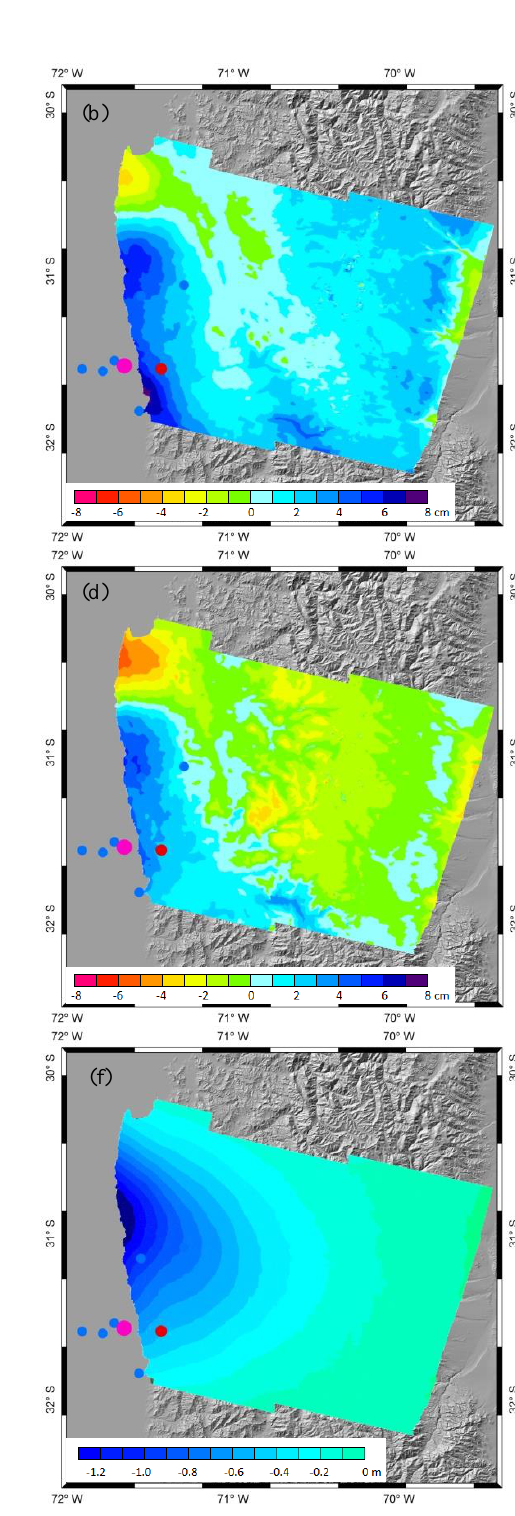
Figure 4. (a) and (b) Post-seismic interferogram of pair 1 (0917_1011) and its unwrapped displacement, (c) and (d) Post- seismic interferogram of pair 2 (0917_1023) and its corresponding unwrapped displacement, (e) and (f) Coseismic interferogram and its unwrapped displacement in the same area for comparison. A fringe indicates 2.8cm LOS displacement. Big pink dot is the epicenter of Mw8.3 mainshock, other color dots show aftershocks with implication same as in